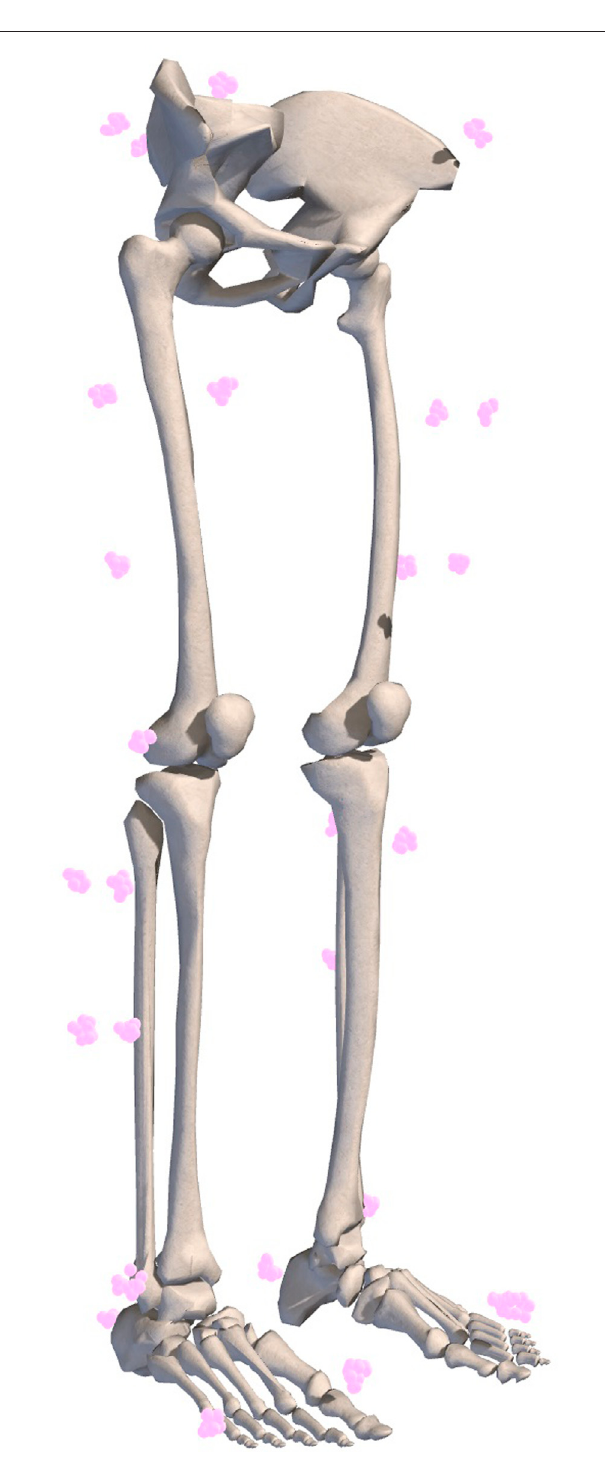
FIGURE 2 | Example of marker registration uncertainty represented by equally probable marker locations. Ten marker sets with 1 cm uncertainty are